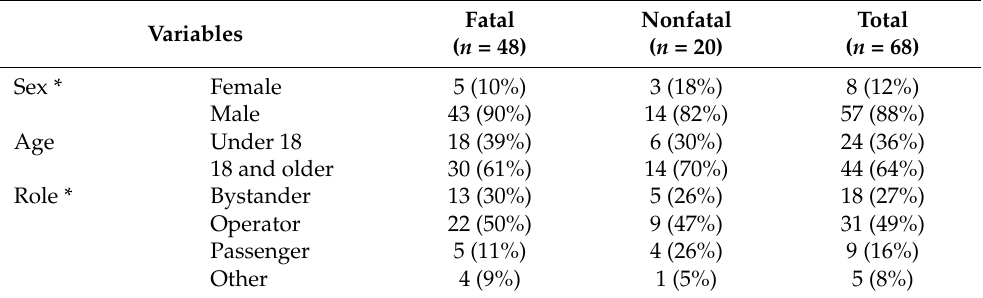
Table 5. Characteristics of injuries for agricultural skid steer injuries from news media.